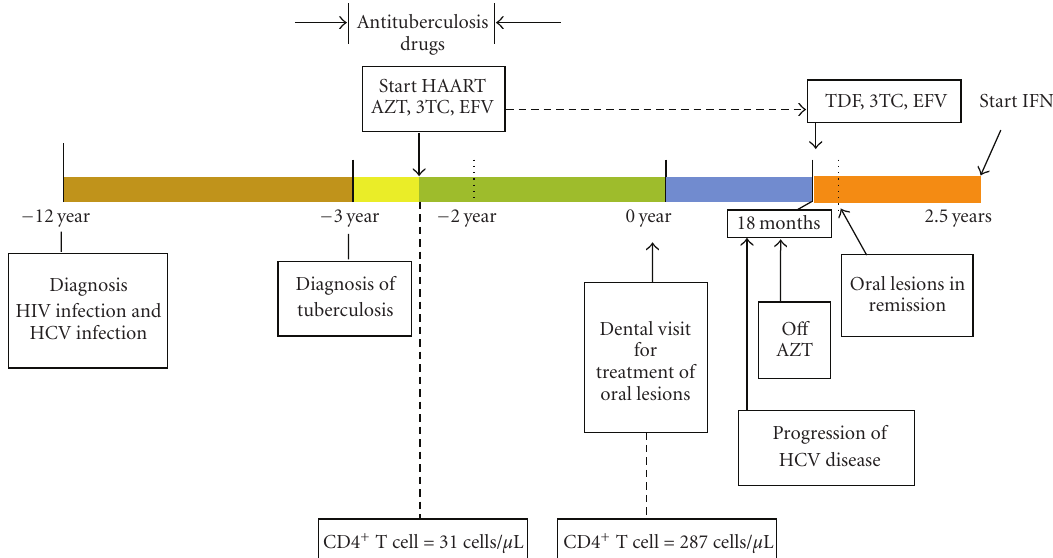
Figure 1: The time line of drug administration, occurrence of the oral lesions, withdrawal of the AZT, and remission of the lesions.